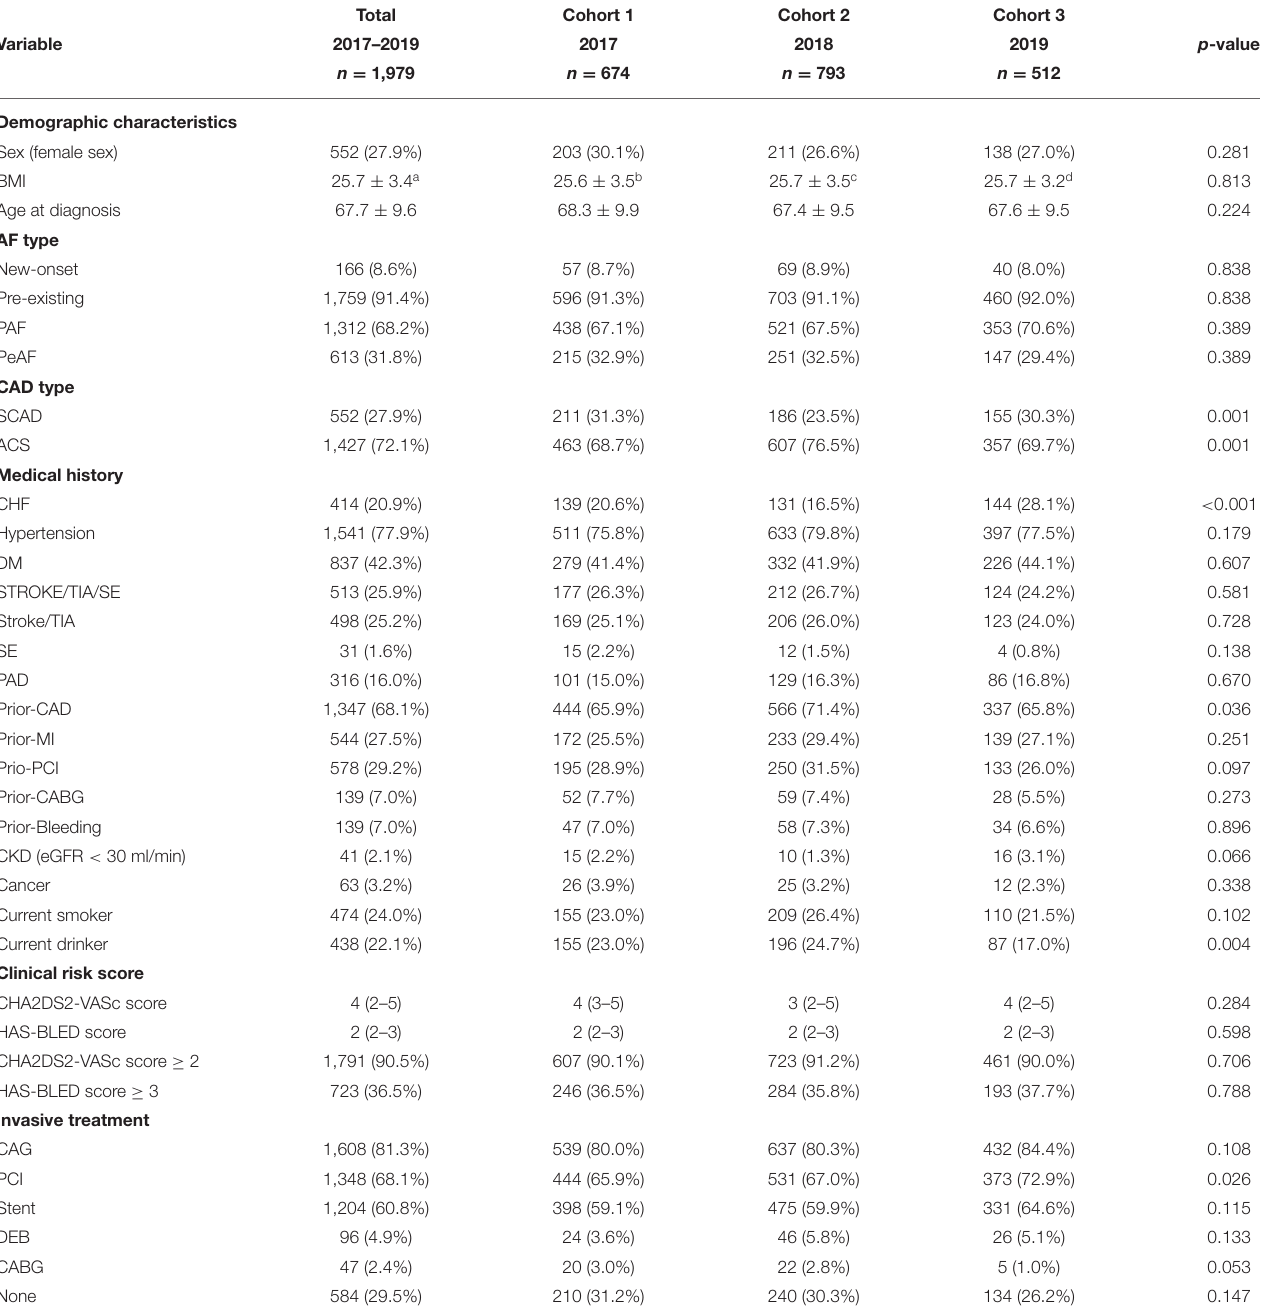
TABLE 1 | Baseline characteristics of the study